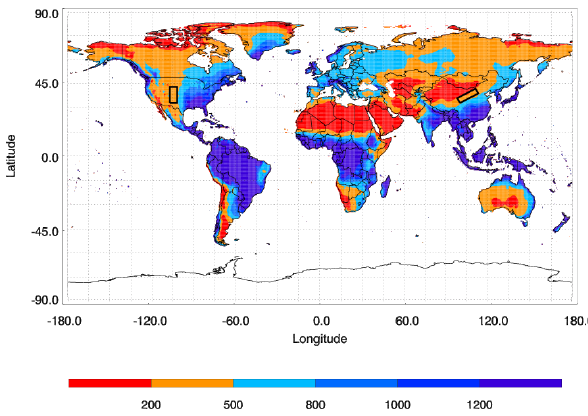
Fig. 1. Global precipitation distribution. The orange color represents the semi-arid regions having annual precipitation ranging from 200 to 500 mm. The black rectangles denote the semi-arid regions over China (CSR) and over the USA (USR) selected for this study.